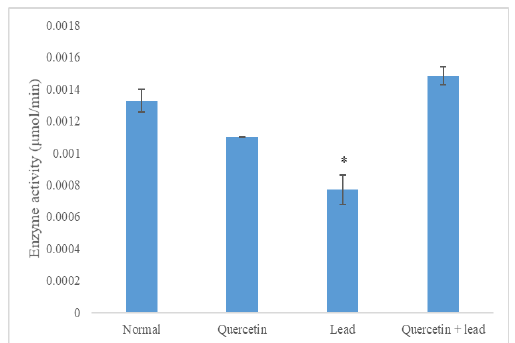
Figure 3.Effects of Quercetin on Glutathione-S- transferase Activity in Lead Treated Drosophila Melanogaster. * = difference significant when compared to normal control group.